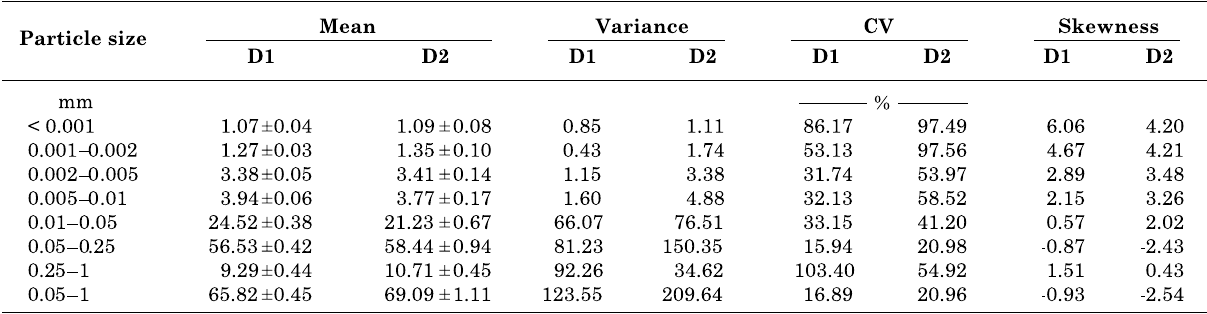
D1, filled deposited farmland soil; D2, silting deposited farmland soil; CV, coefficient of variation.